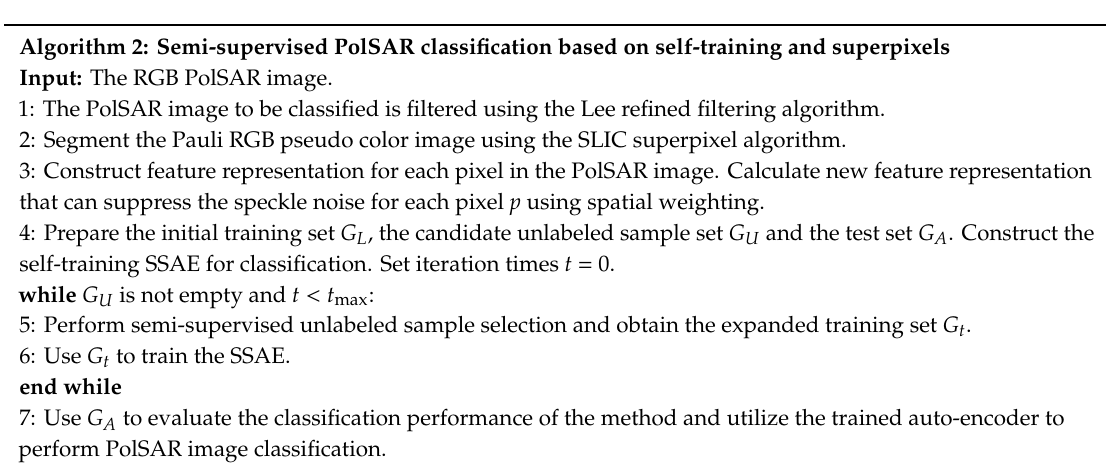
Algorithm 2: Semi-supervised PolSAR classification based on self-training and